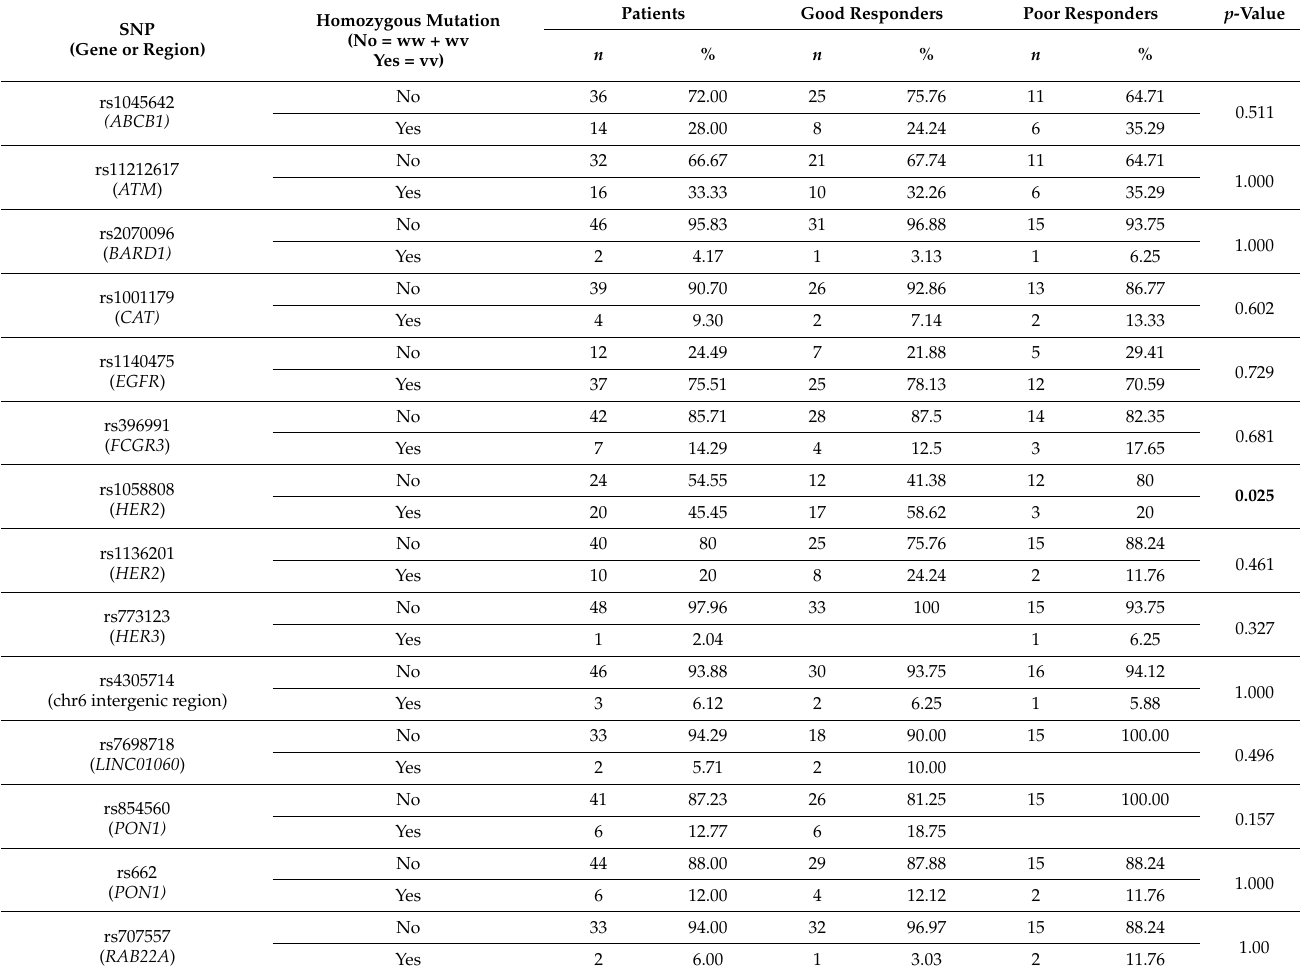
Table 3. Genotype frequencies (homozygous mutation versus the rest) in good responders and poor responders for 14 SNPs. p -value corresponds to Fisher’s exact test. Significant value is highlighted in bold. w = wild-type allele and v = variant allele.